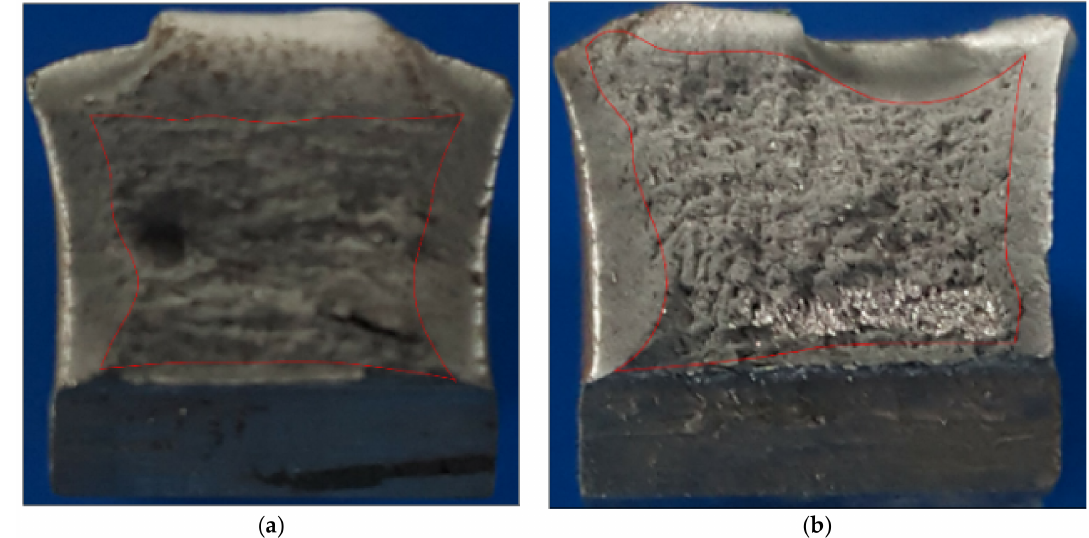
Figure 16. Comparison of shear fracture appearance between two specimens, ( a ) 1S-CI-HAZ (56%) and ( b ) 3F-CI-FZ